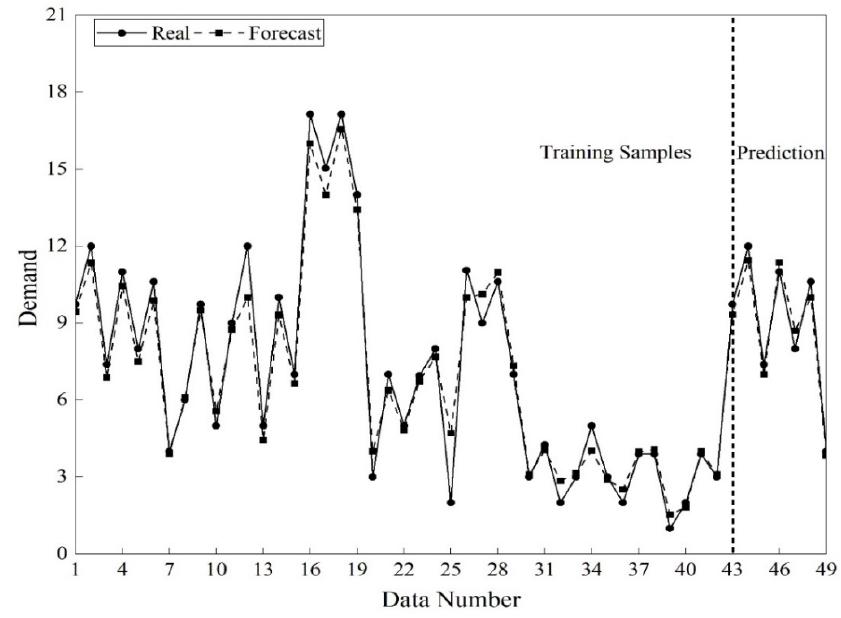
Figure 7. Fitting effect of BP neural network. Table 10. BP neural network forecast results based on different estimation methods.